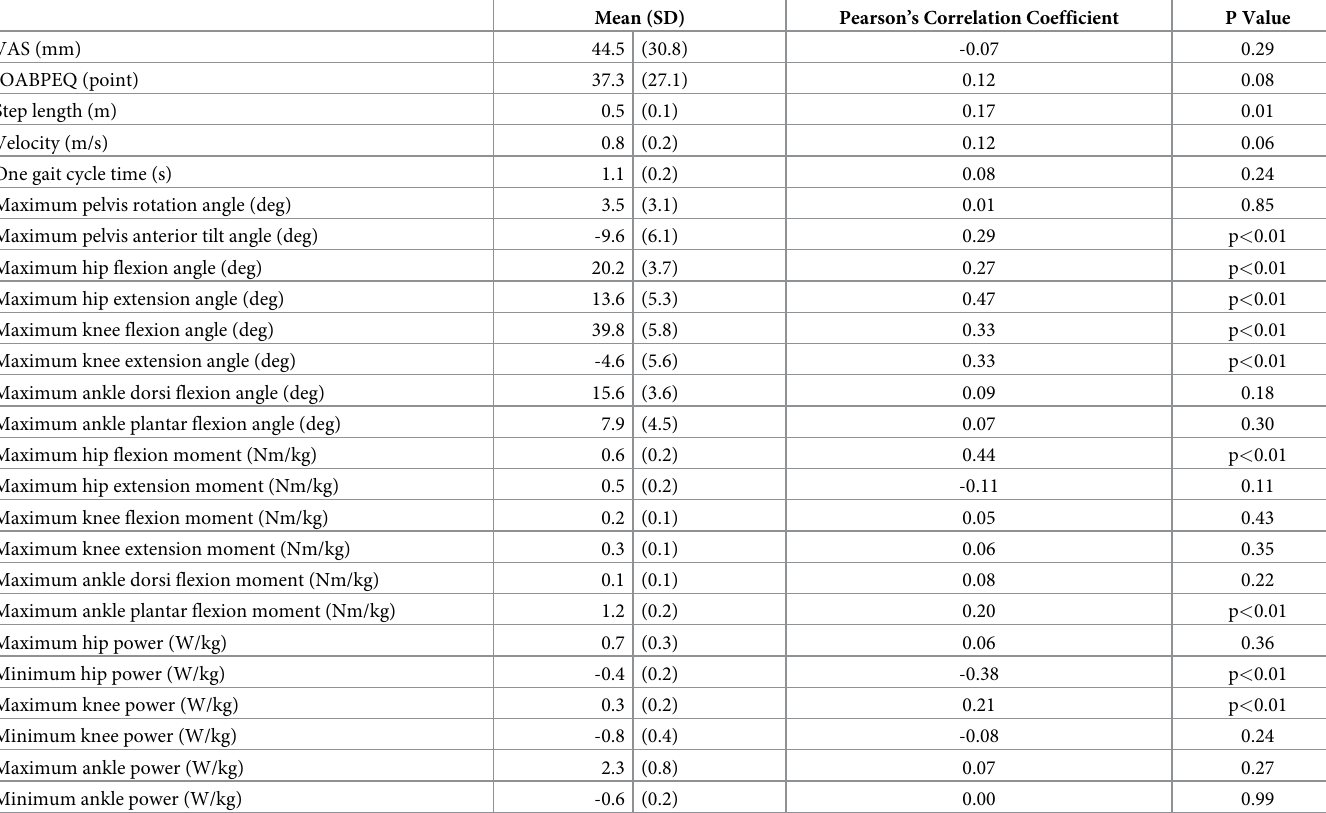
Table 2. Correlation analysis of variables possibly associated with the maximum trunk flexion angle (n =